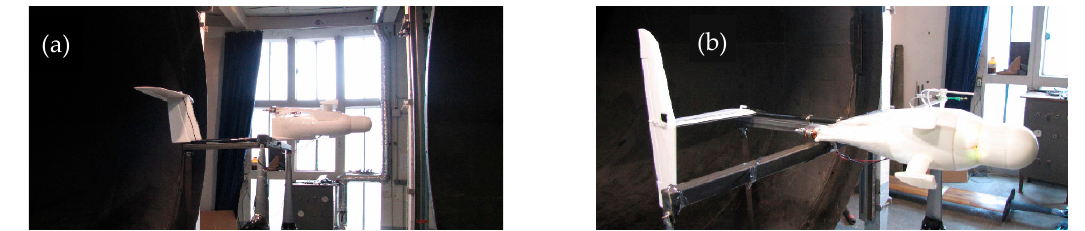
Figure 6. OVLI-TA during the wind tunnel test: ( a ) angle of attack testing; and ( b ) angle of sideslip testing [19].